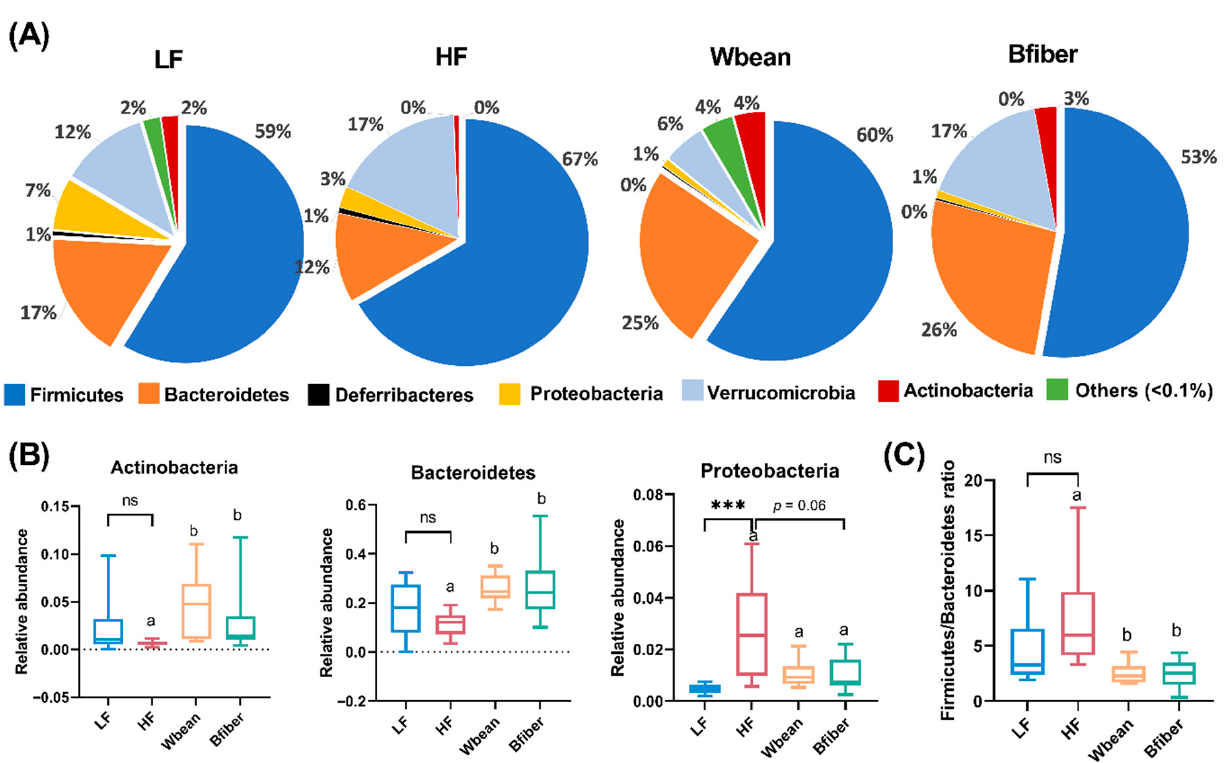
Figure 5. ( A ) Relative abundance at phylum level of different gut microbial taxa and significant differences in ( B ) phyla and ( C ) Firmicutes/Bacteroidetes ratio detected for cecal samples from mice fed the low fat (LF), high fat (HF), whole brown bean (Wbean), or bean fiber (Bfiber) diet for 10.5 weeks. Values in the LF and HF groups were compared using Welch’s t -test (or Mann–Whitney test for nonparametric data). Values in the high fat groups, i.e., HF, Wbean, and Bfiber, were compared using one-way ANOVA (Welch’s ANOVA test for data with unequal SDs, or Kruskal–Wallis test for nonparametric data) followed by post hoc tests. Different lowercase letters within panels cate significant differences ( p < 0.05). ns: not significant. *** p < 0.001.